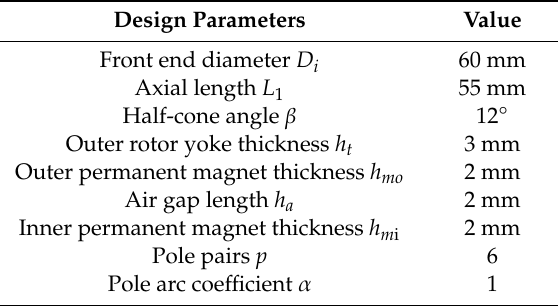
Table 1. Main parameters of the initially designed